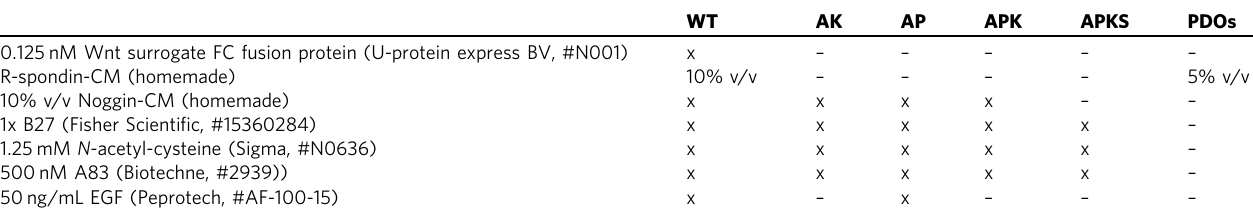
Table 3 Differentiation medium composition for tumor progression organoids and patient-derived organoids